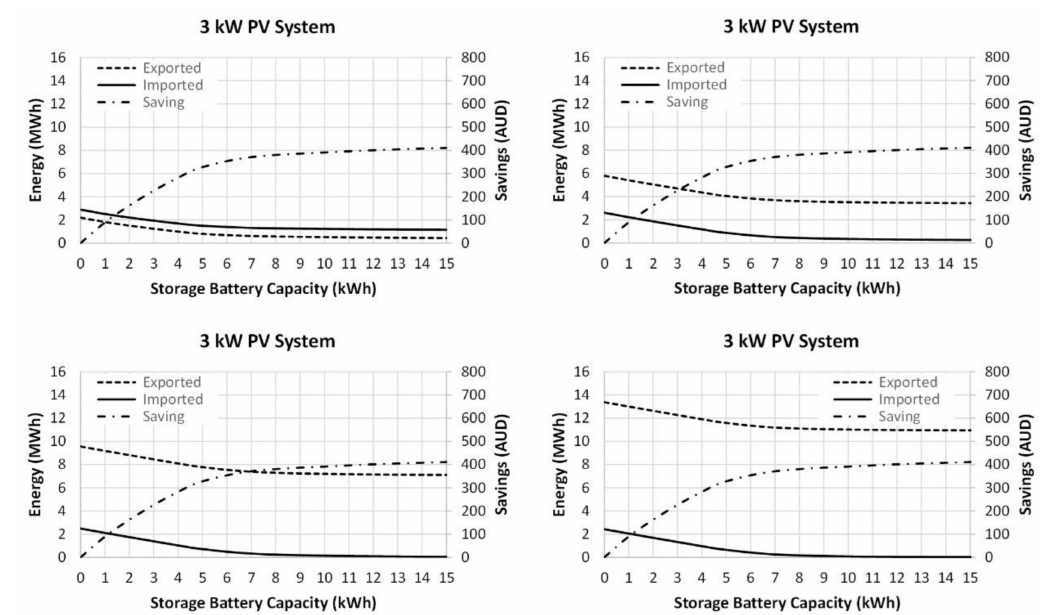
Figure 10. House 3: Energy flows and cost savings as a function of battery